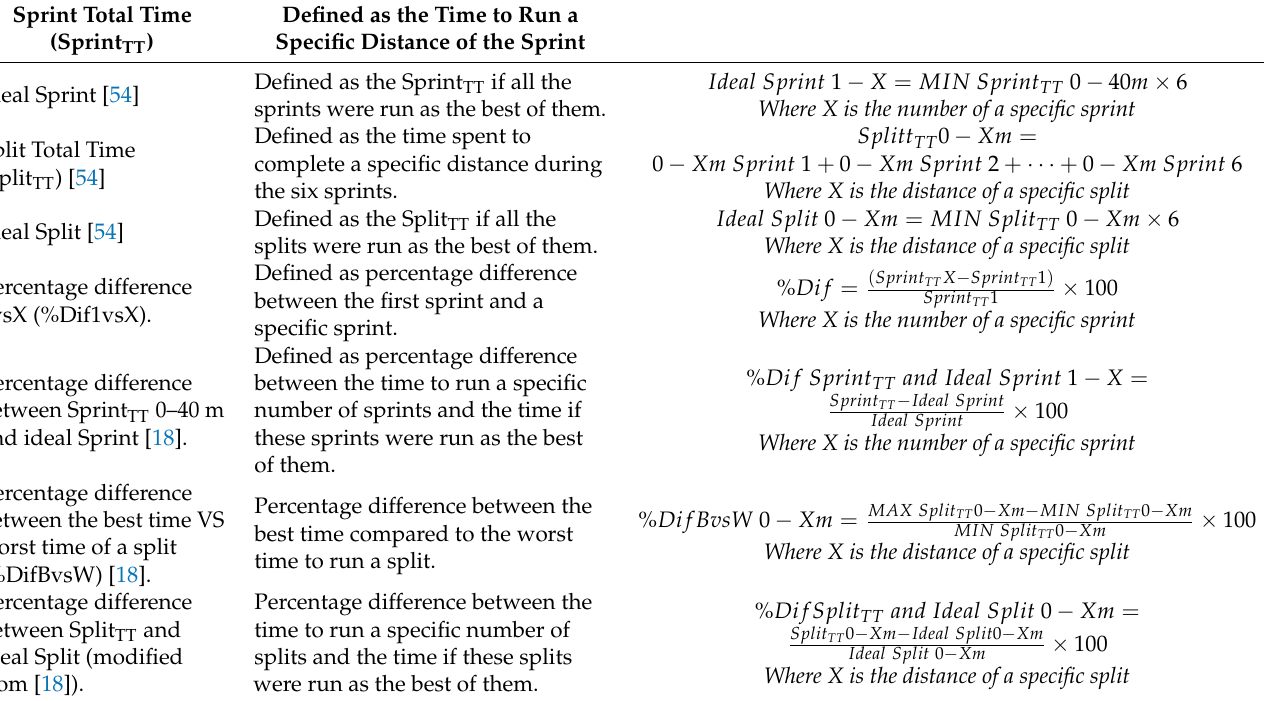
Table 1. Calculations of the different variables to evaluate fatigue during the RSA test.